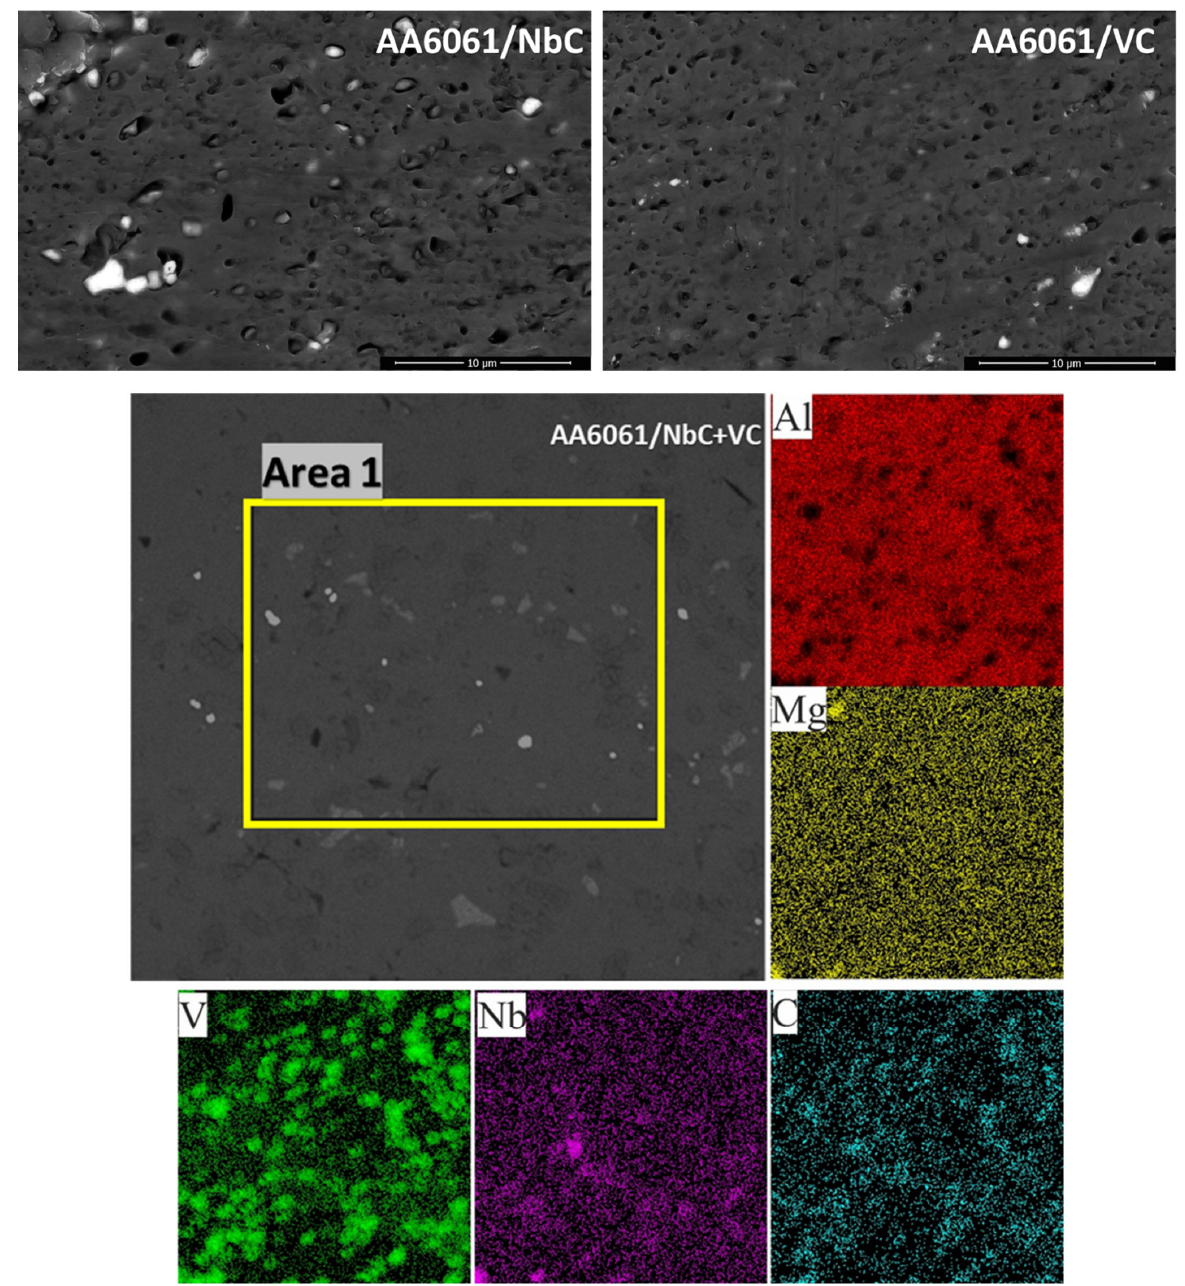
Figure 4. SEM microstructure of the mono ‐ composites AA6061/NbC and AA6061/VC, and the EDS maps of the manufactured hybrid composite AA6061/NbC +